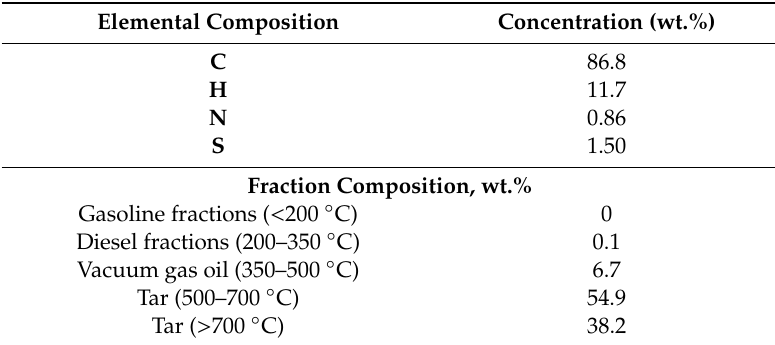
Table 1. Characteristics of the studied